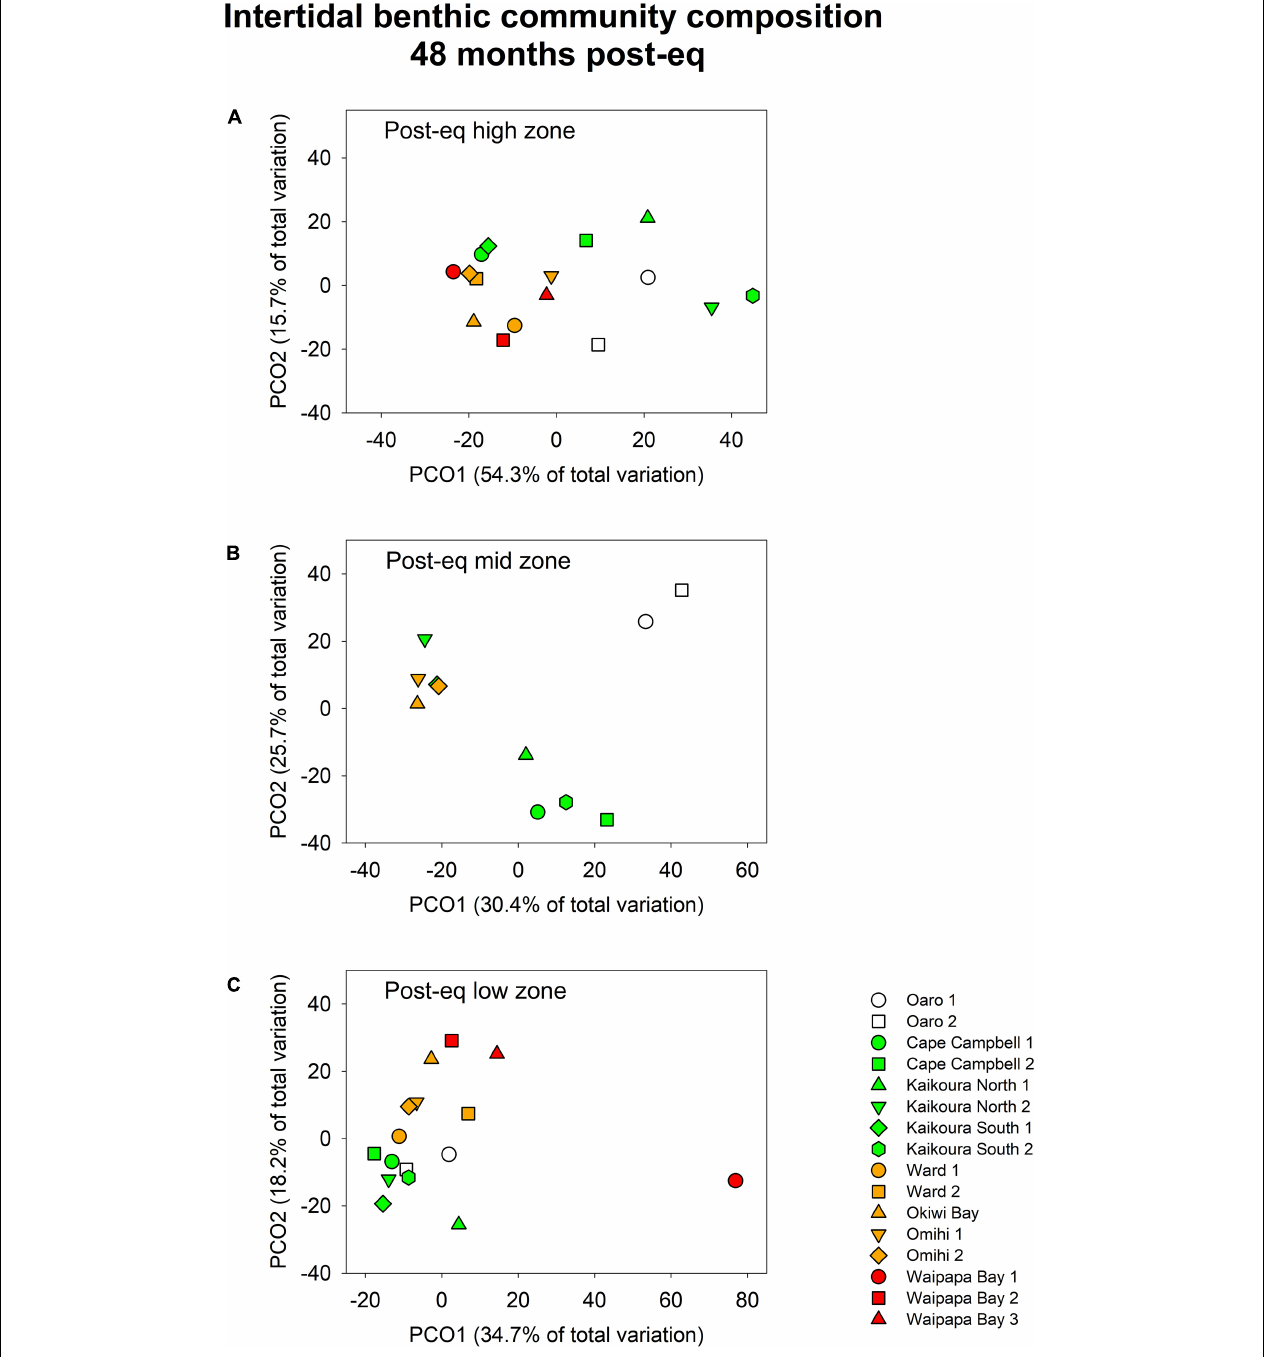
FIGURE 9 | Principal coordinates analysis (PCO) plots showing differences in the composition of benthic communities in the post-earthquake high (A) , mid (B) and low zone (C) across sites with different degrees of uplift 48 months after the earthquake. The symbols represent the centroid of each site and the colors the different levels of uplift (white = no uplift, green = low uplift, yellow = medium uplift, red = high uplift). Sites are ordered north to south within each uplift group. Only the high and the low zone were sampled at high-uplift